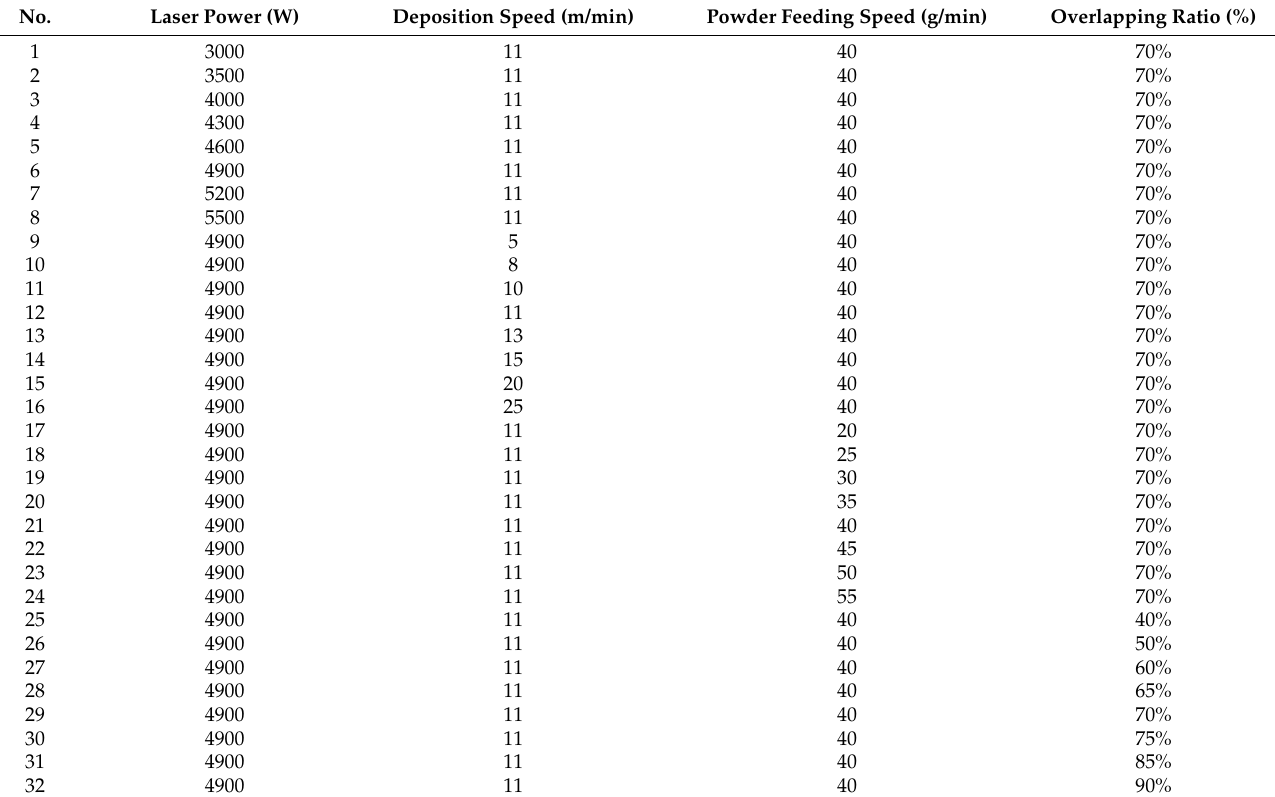
Table 3. Experiment scheme for simulating process parameter